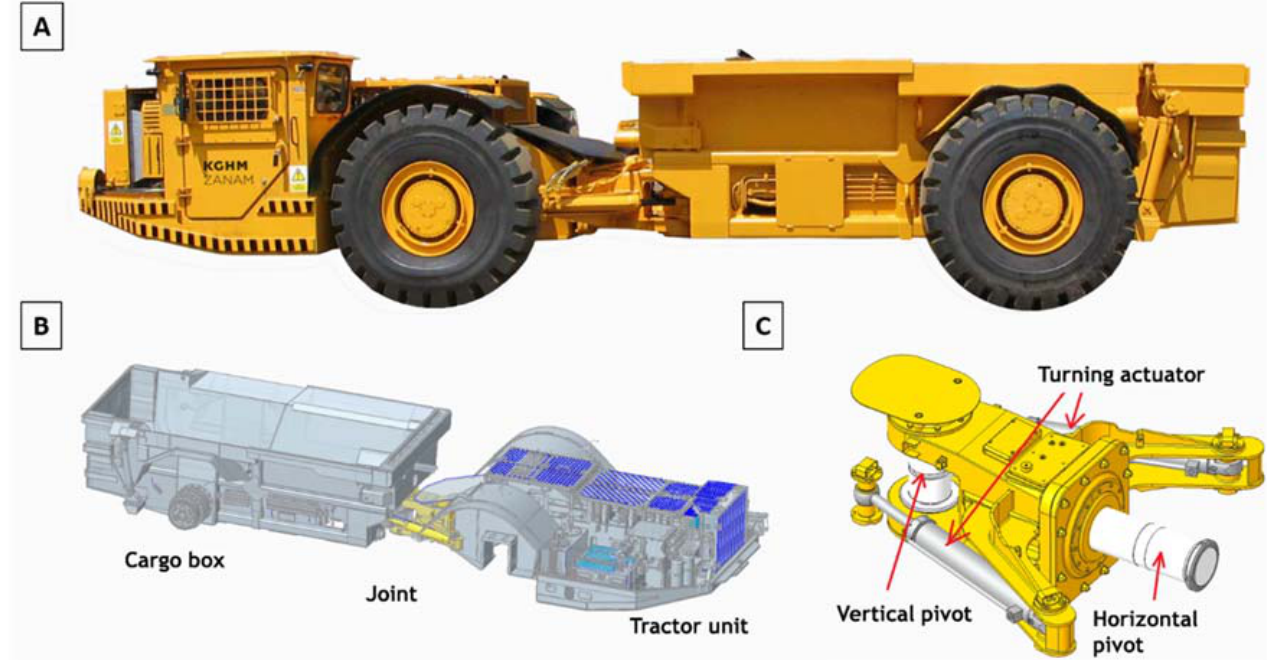
Figure 1. Investigated object: ( A ) haul truck, ( B ) main structural parts, ( C ) the construction of the